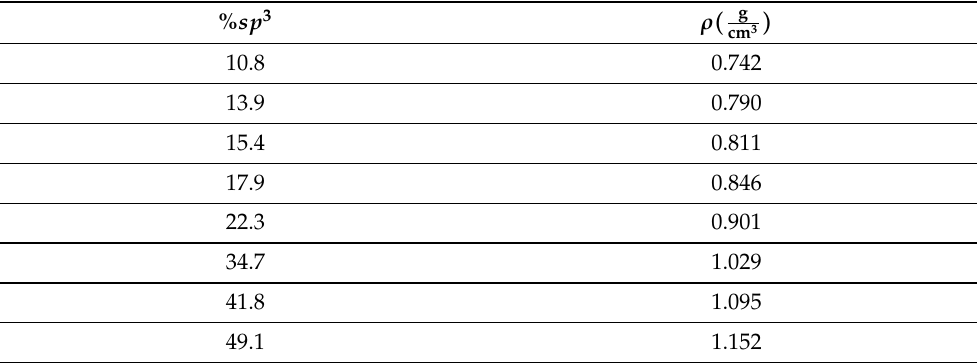
Table 1. Calculated density of carbon foams with a porosity of 50% for each % sp 3